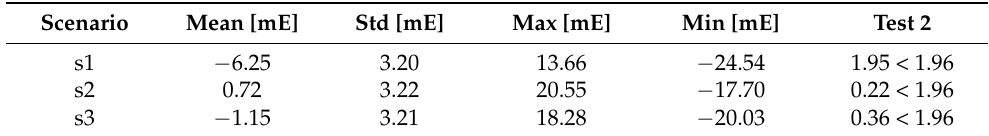
Table 5. Statistic on the differences between the forwarded gravitational signal from revised algo- rithm solution and from the “true” model, (cid:98) T R rr − T true rr , for the three tested scenarios. The test 2 is implemented as in Equation (33) by replacing (cid:98) T O rr with T true rr